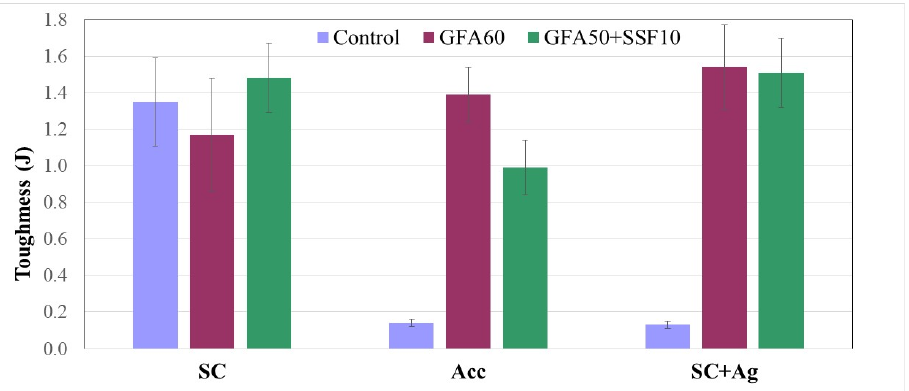
Figure 3. Toughness of the GRC composites. (SC, standard curing for 28 d at 20 °C; CS+Ag, 28 d SC plus aging for 28 d at 55 °C; Acc, short curing for 7 d at 20 °C plus Acc for 21 d at 55 °C).